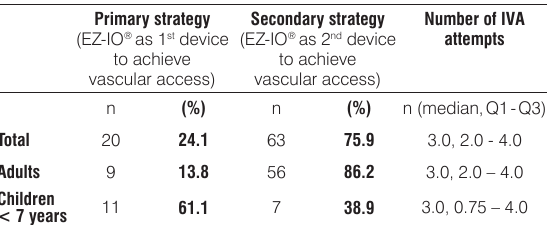
Table 1. Indication for